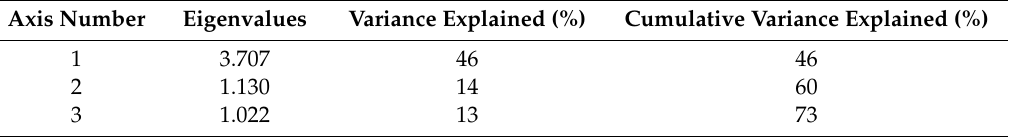
Table 2. Eigenvalues and the explained variance by the first three PCA components on the completed environmental